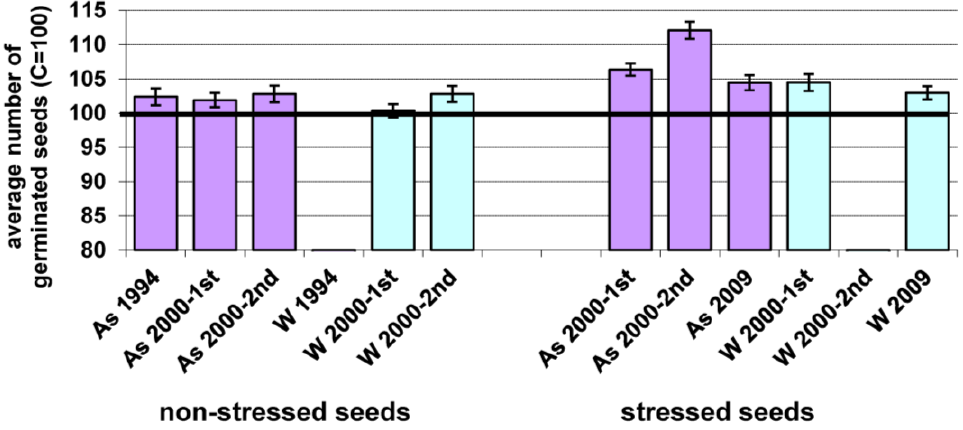
FIGURE 3 . Average number of germinated seeds in each experiment (control = 100). Bars indicate standard errors of average